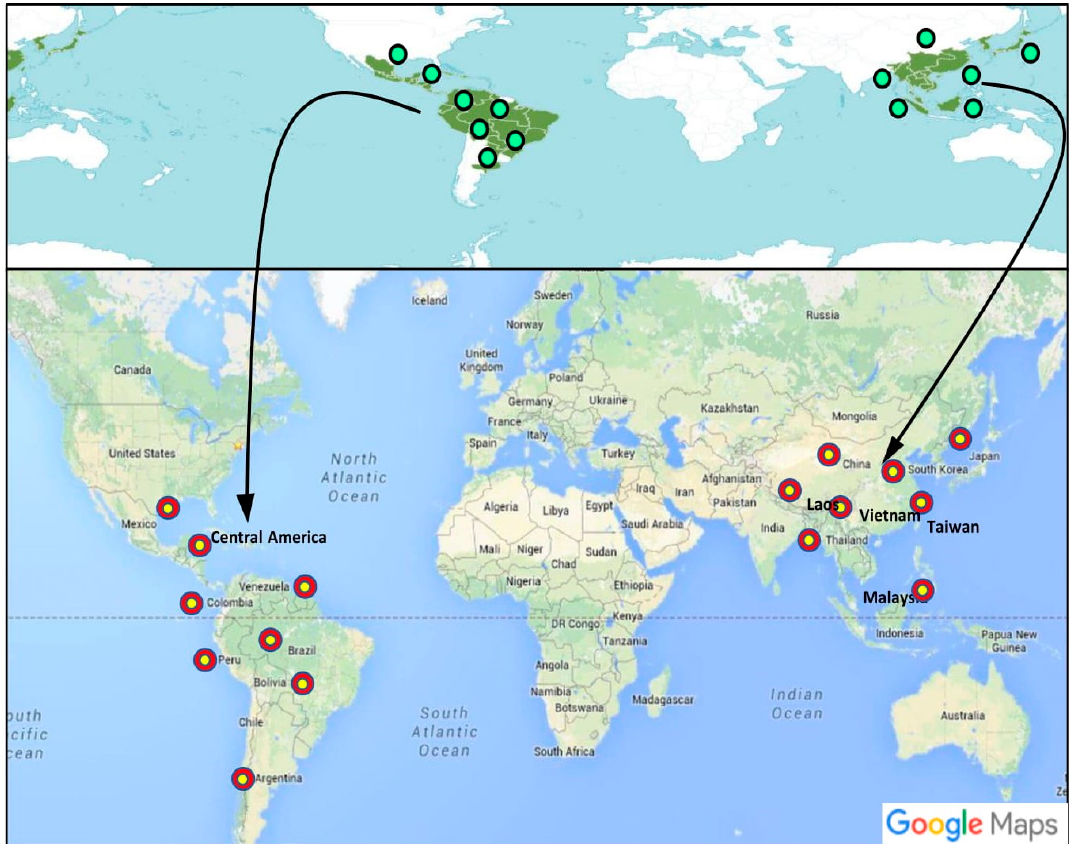
Figure 2. Global distribution (Green dots) map of Dendropanax showing the abundance in worldwide (http://www.ipni.org and http://apps.kew.org/wcsp/). The Google maps occurrence of the species within southwestern region countries is shown in red dots (https://images.app.goo.gl/wCJHWkM4fDJBFakr5).